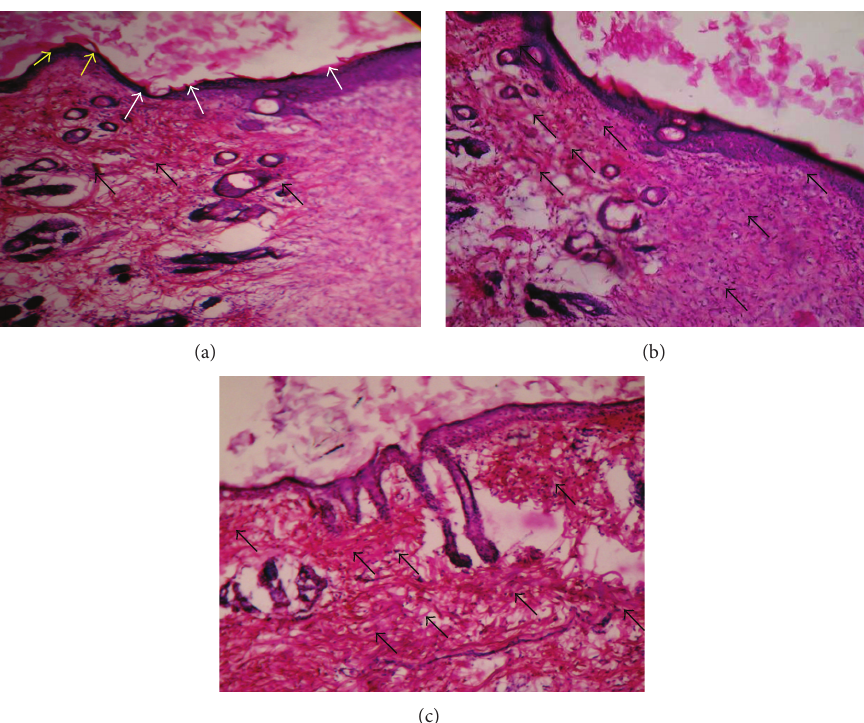
Figure 3: Histopathology of skin at day 10 stained with H&E (100x). (a) Skin of control rat showing ulceration and edema showed by white arrow, early epithelization showed by yellow arrow, and granulation tissue and abundance of mononuclear inflammatory cells showed by black arrow. (b) AME treated rats showing large amount of granulation tissue by black arrow, small number of mononuclear inflammatory cells, and restoration of adnexa and extensive fibrosis. (c) VTE treated rats showing healed skin structures with near to normal epidermis, restoration of adnexa and extensive fibrosis and collagen tissue within the dermis.